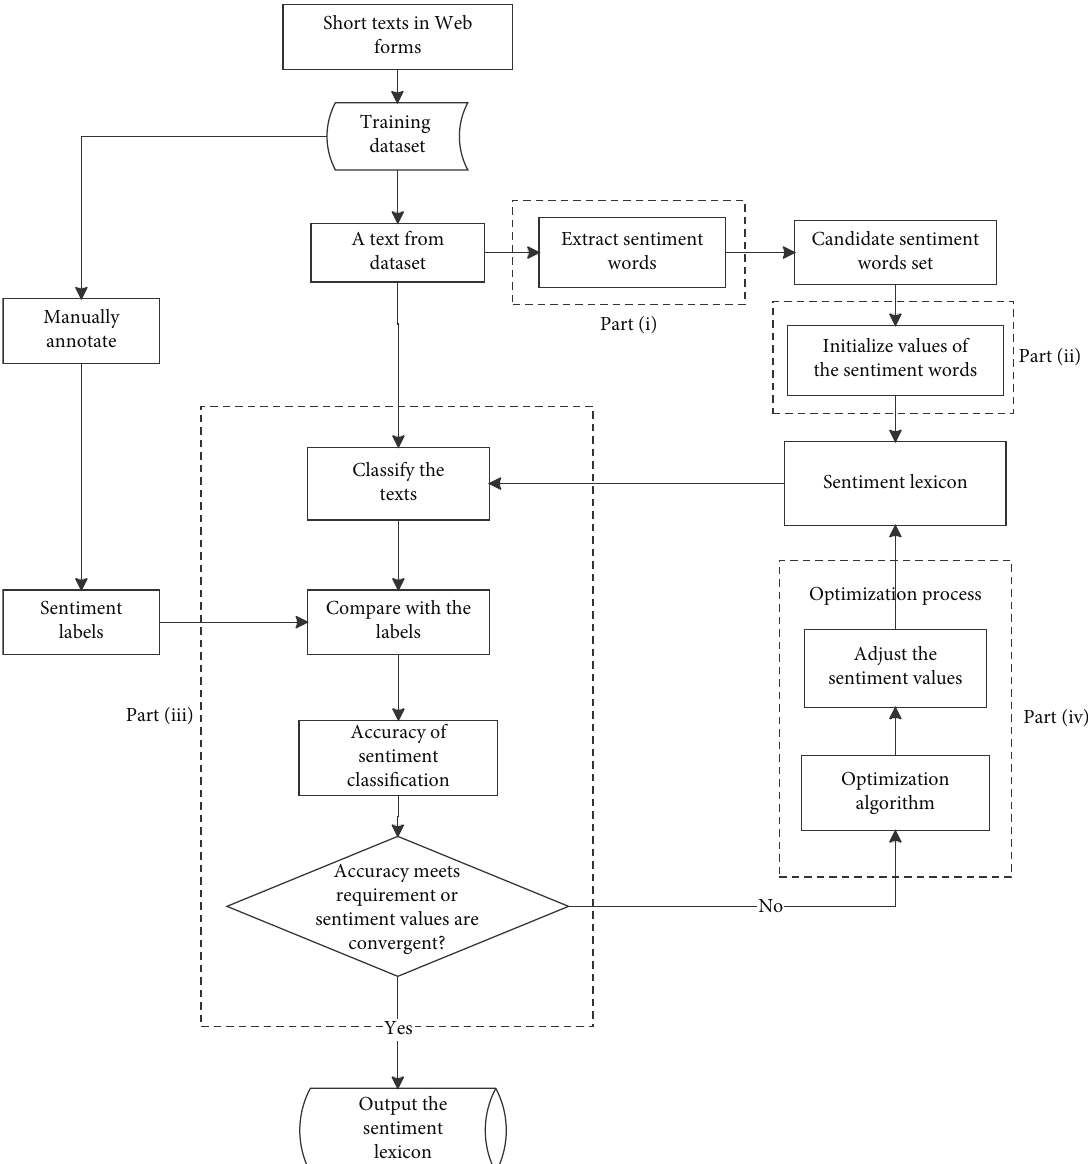
Figure 1: The proposed framework for constructing sentiment lexicon, which includes four main parts. Part (i): sentiment words extraction; Part (ii): sentiment values initialization; Part (iii): sentiment classification and evaluation; Part (iv): adjusting sentiment